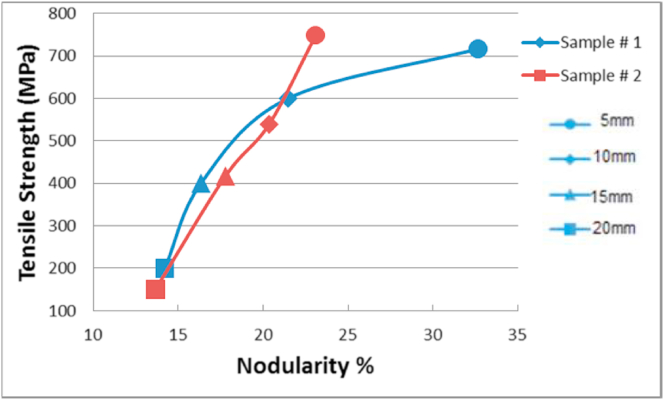
Tensile strength of 80–100% pearlite content as a function of Nodularity.